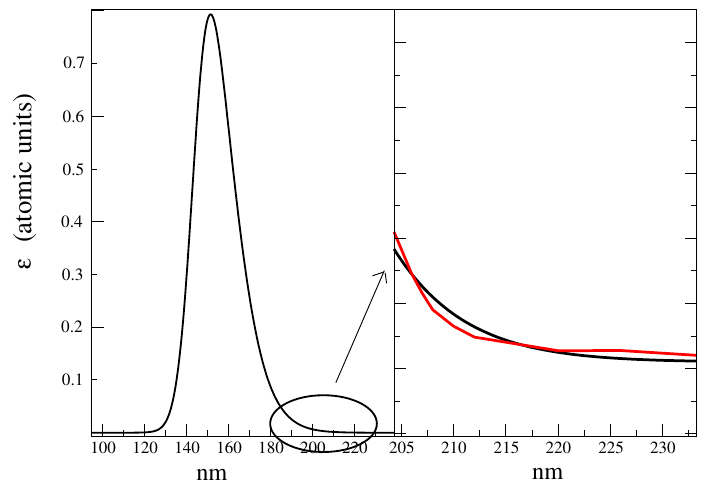
Figure 7. Left panel: Calculated UV absorption spectrum of D -glucose in a water solution. Right panel: Detail of the highlighted red-tail region of the calculated (black) and experimental (red) UV absorption spectrum of D -glucose in a water